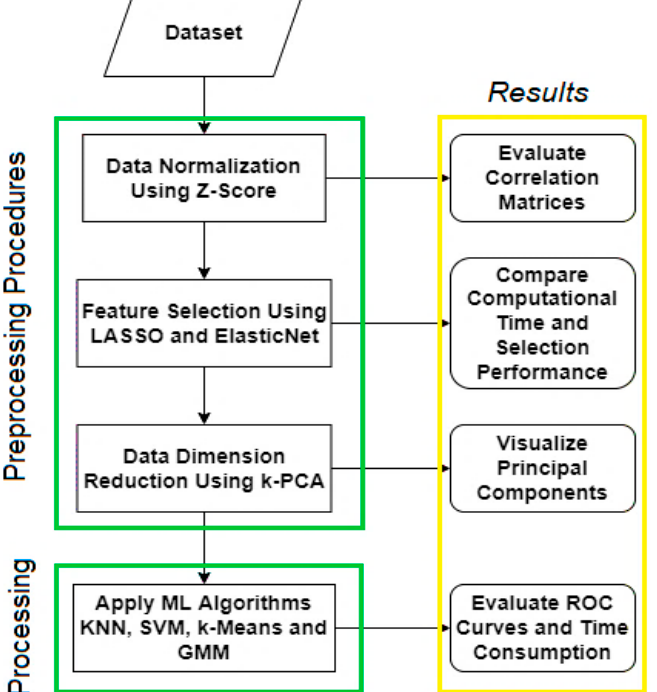
Figure 3. Model planning procedures: data preprocessing, data ML processing, and model evalua- tion.